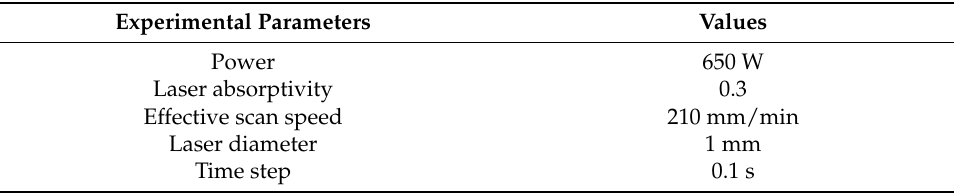
Table 4. Input parameters for the numerical simulation.